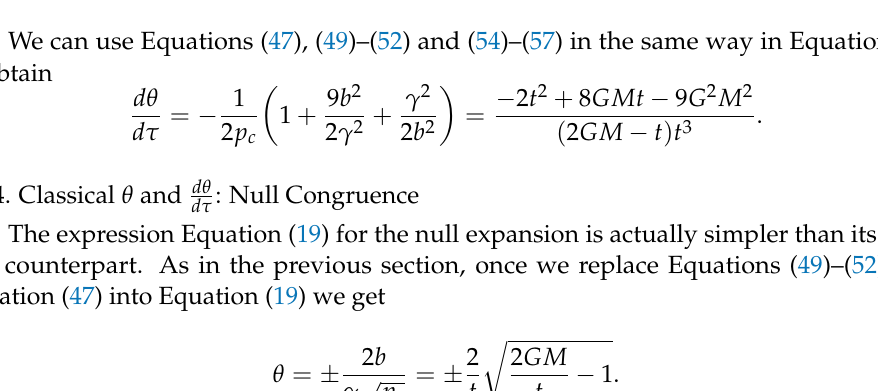
Figure 1. Classical timelike θ and d θ diverge as we approach t → 0. The divergence at the horizon is d τ due to the choice of Schwarzschild coordinate system. The dashed line is where θ changes